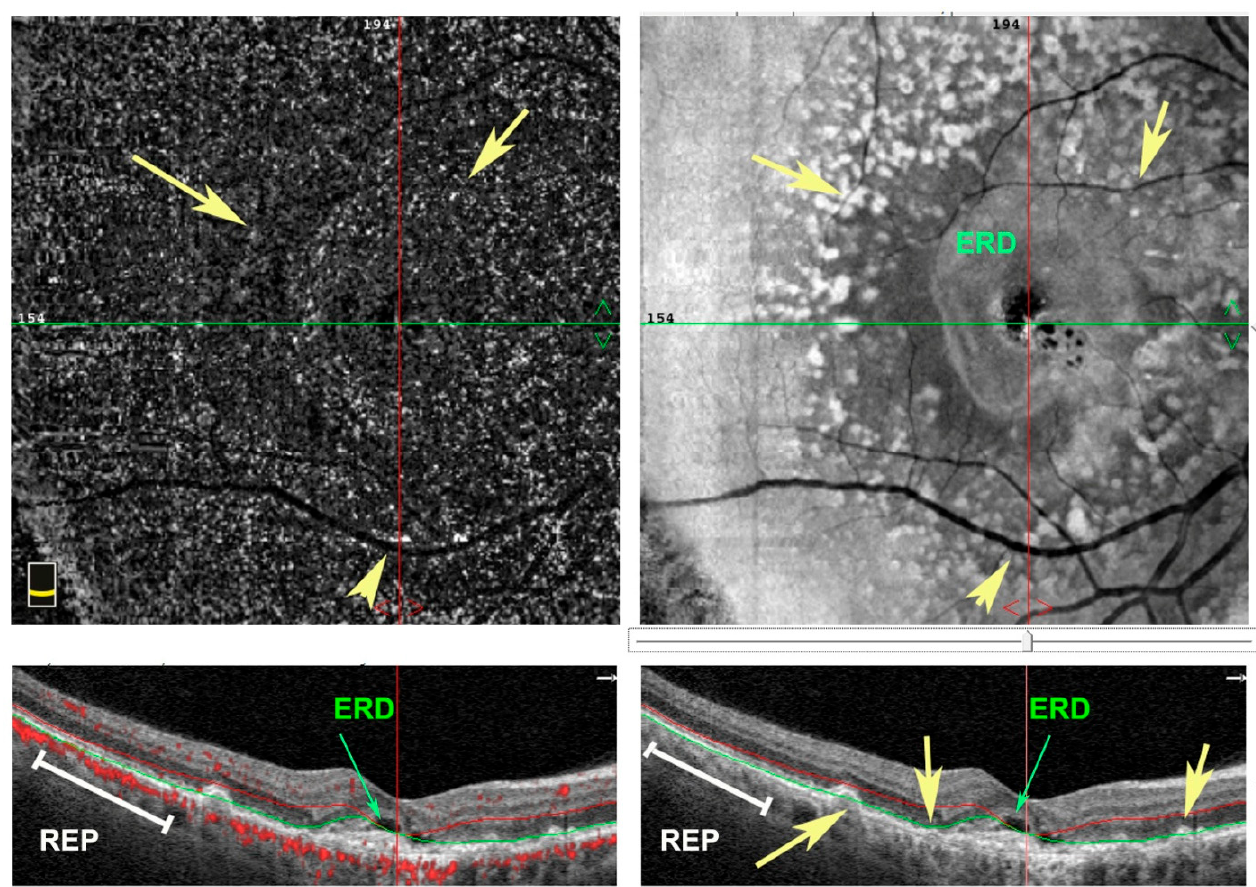
Figure 1. En face ( upper panel) and structural B-scan ( bottom panel) images of spectral domain-optical coherence tomography (SD-OCT) of a right eye. Patient affected by wet age-related macular degeneration (AMD) with exudative retinal detachment (ERD) in the foveal area. Numerous drusen deposits as hyperfluorescent dots (yellow arrows) are under retinal pigment epithelium (RPE) (white lines).